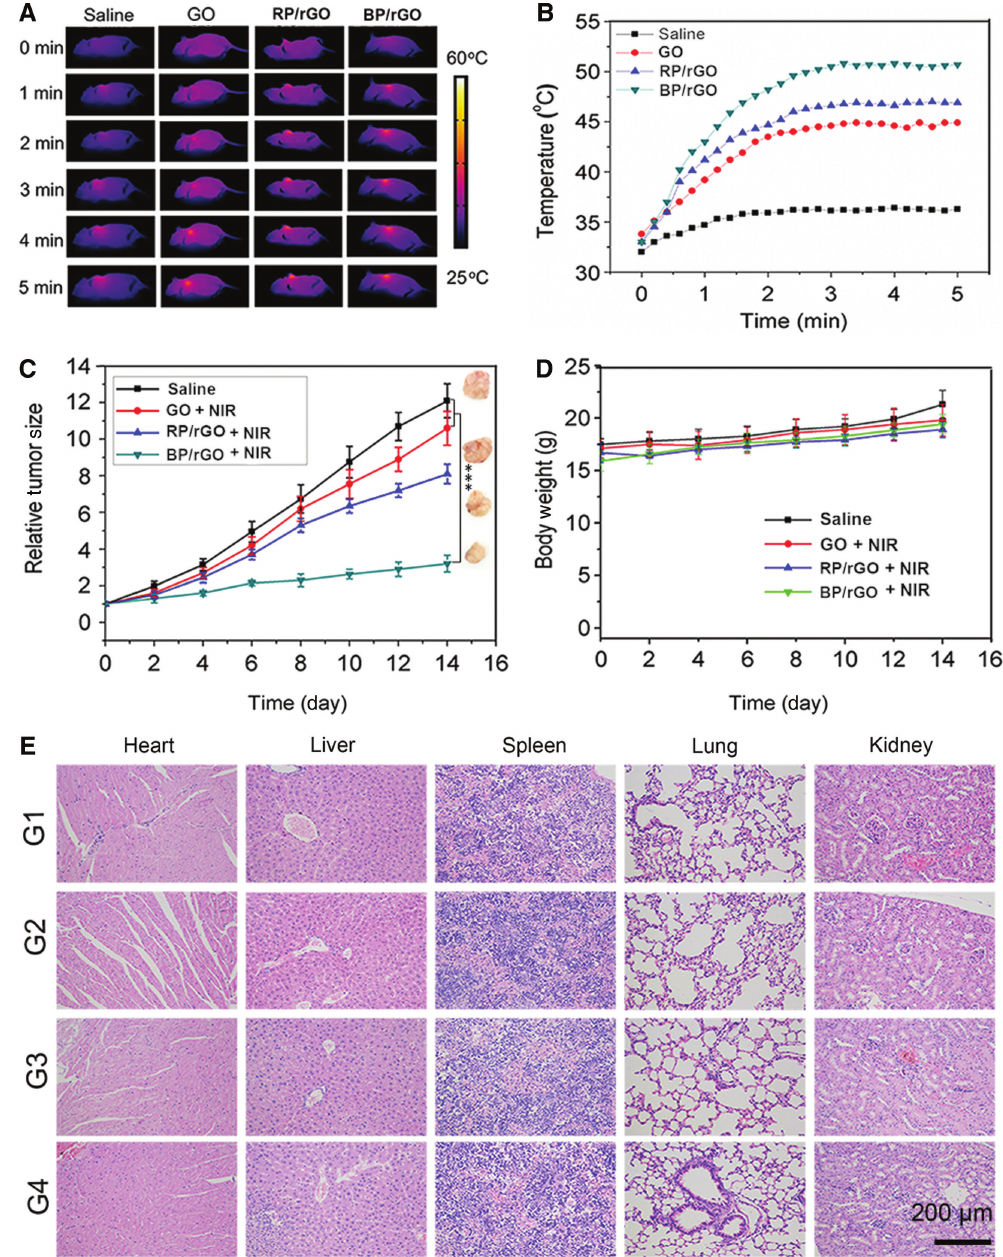
Figure 6: In vivo IR thermal imaging and photothermal anti-cancer activities of PEG-coated BP/rGO. (A) Real-time IR thermal photos of SMCC-7721 tumor-bearing nude mice exposed to a NIR-laser (808 nm, 1.0 W cm −2 , 5 min) after intratumor injection of PEGylated BP/rGO (10 μ g per mouse). (B) Real-time temperature changes of tumor sites during laser exposure corresponding to A). (C) Typical photographs and corresponding growth curves of tumors collected from the mice treated with saline solution, PEGylated GO with NIR laser irradiation, PEGylated RP/rGO with NIR laser irradiation, and PEGylated BP/rGO with NIR laser irradiation. All the relative tumor volumes were normalized to the initial sizes. Data were shown as mean ± SD, ***p < 0.001, n = 5, Dunnett’s multiple comparison test. (D) Body weight of nude mice measured every 2 days under various treatment conditions as shown in C). (E) H&E stained images of typical tissues from mice treated with G1 (saline solution), G2 (PEGylated GO with laser irradiation), G3 (PEGylated RP/rGO with laser irradiation), and G4 (PEGylated BP/rGO) with laser